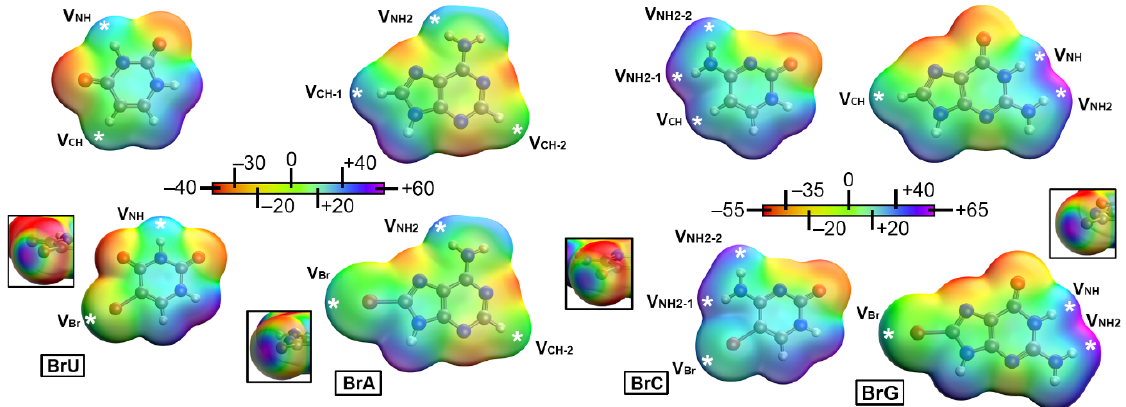
Figure 3. Molecular Electrostatic potential (MEP) surfaces of bromouracil (BrU), bromocytosine (BrC), bromoadenine (BrA), and bromoguanine (BrG). The σ -hole present in the halogen atom (Br